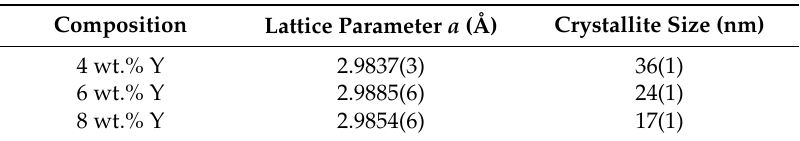
Table 6. Lattice parameter and crystallite size of the TiFe phase in as-cast TiFe + x wt.% Y alloys ( x = 4, 6 and 8). Uncertainties on the last significant digit are in